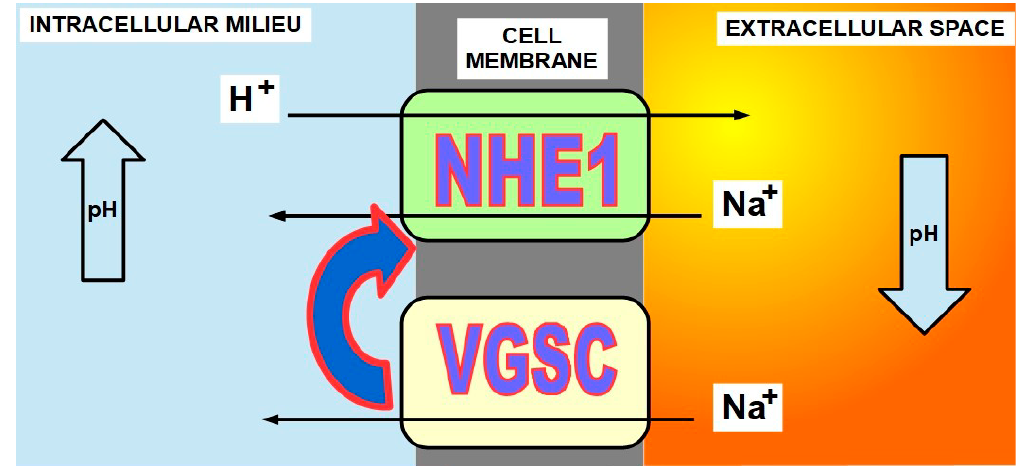
Figure 3. Mechanism of action of NHE1 and VGSCs. NHE1 is an exchanger that imports sodium ions while exporting protons (hydrogen ions). This proton removal from the cell increases intracellular pH while it increases in the extracellular space. VGSCs import sodium ions but do not export